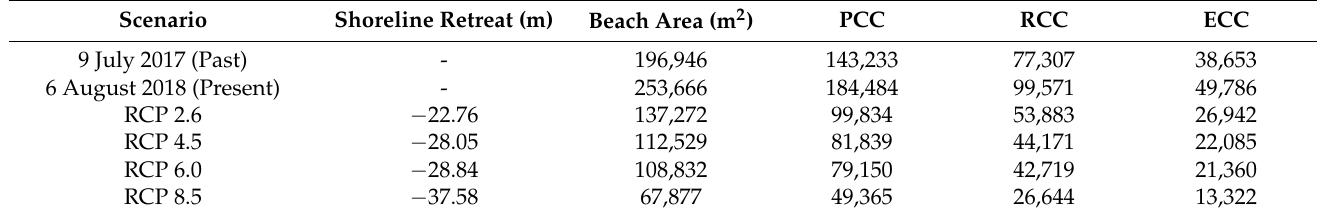
Table 3. Chalatat beach.